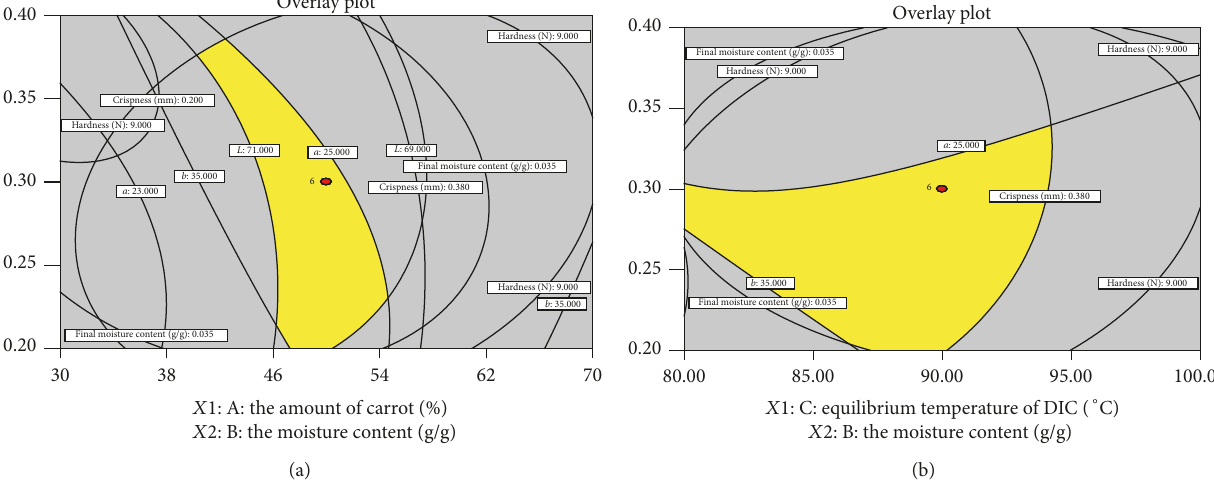
Figure 5: Overlaid contours for (a) the amount of carrot and the moisture content of the partially dried product before DIC treatment to optimize the qualities of the restructured carrot-potato chips at 90 ∘ C equilibrium temperature of DIC and (b) for the moisture content of the partially dried product before DIC treatment and equilibrium temperature of DIC to optimize the qualities of the restructured carrot-potato chips at 50%